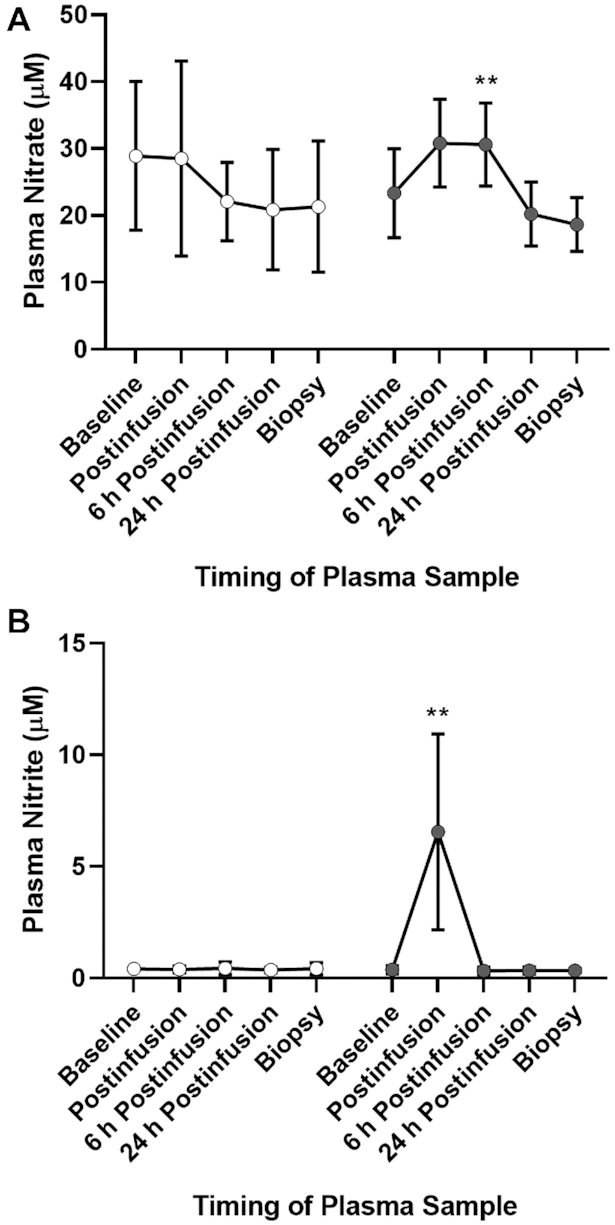
Plasma concentrations of \documentclass[12pt]{minimal}
\usepackage{amsmath}
\usepackage{wasysym}
\usepackage{amsfonts}
\usepackage{amssymb}
\usepackage{amsbsy}
\usepackage{upgreek}
\usepackage{mathrsfs}
\setlength{\oddsidemargin}{-69pt}
\begin{document}
}{}${\rm{NO}}_3^ - $\end{document} and \documentclass[12pt]{minimal}
\usepackage{amsmath}
\usepackage{wasysym}
\usepackage{amsfonts}
\usepackage{amssymb}
\usepackage{amsbsy}
\usepackage{upgreek}
\usepackage{mathrsfs}
\setlength{\oddsidemargin}{-69pt}
\begin{document}
}{}${\rm{NO}}_2^ - $\end{document} in humans over time in response to a 30-min bolus injection of sodium nitrite or saline placebo (see the Methods section for details). (A) Plasma \documentclass[12pt]{minimal}
\usepackage{amsmath}
\usepackage{wasysym}
\usepackage{amsfonts}
\usepackage{amssymb}
\usepackage{amsbsy}
\usepackage{upgreek}
\usepackage{mathrsfs}
\setlength{\oddsidemargin}{-69pt}
\begin{document}
}{}${\rm{NO}}_3^ - $\end{document} concentrations were significantly increased 6 h postinfusion in patients receiving intravenous sodium nitrite (F[1,18] = 9.44). **Significant differences: **P < 0.01. (B) Plasma \documentclass[12pt]{minimal}
\usepackage{amsmath}
\usepackage{wasysym}
\usepackage{amsfonts}
\usepackage{amssymb}
\usepackage{amsbsy}
\usepackage{upgreek}
\usepackage{mathrsfs}
\setlength{\oddsidemargin}{-69pt}
\begin{document}
}{}${\rm{NO}}_2^ - $\end{document} concentrations were significantly increased immediately postinfusion in patients receiving intravenous sodium nitrite (F[1,32] = 27.342). **Significant differences: **P < 0.01. White circles, NaCl; gray circles, NaNO2.